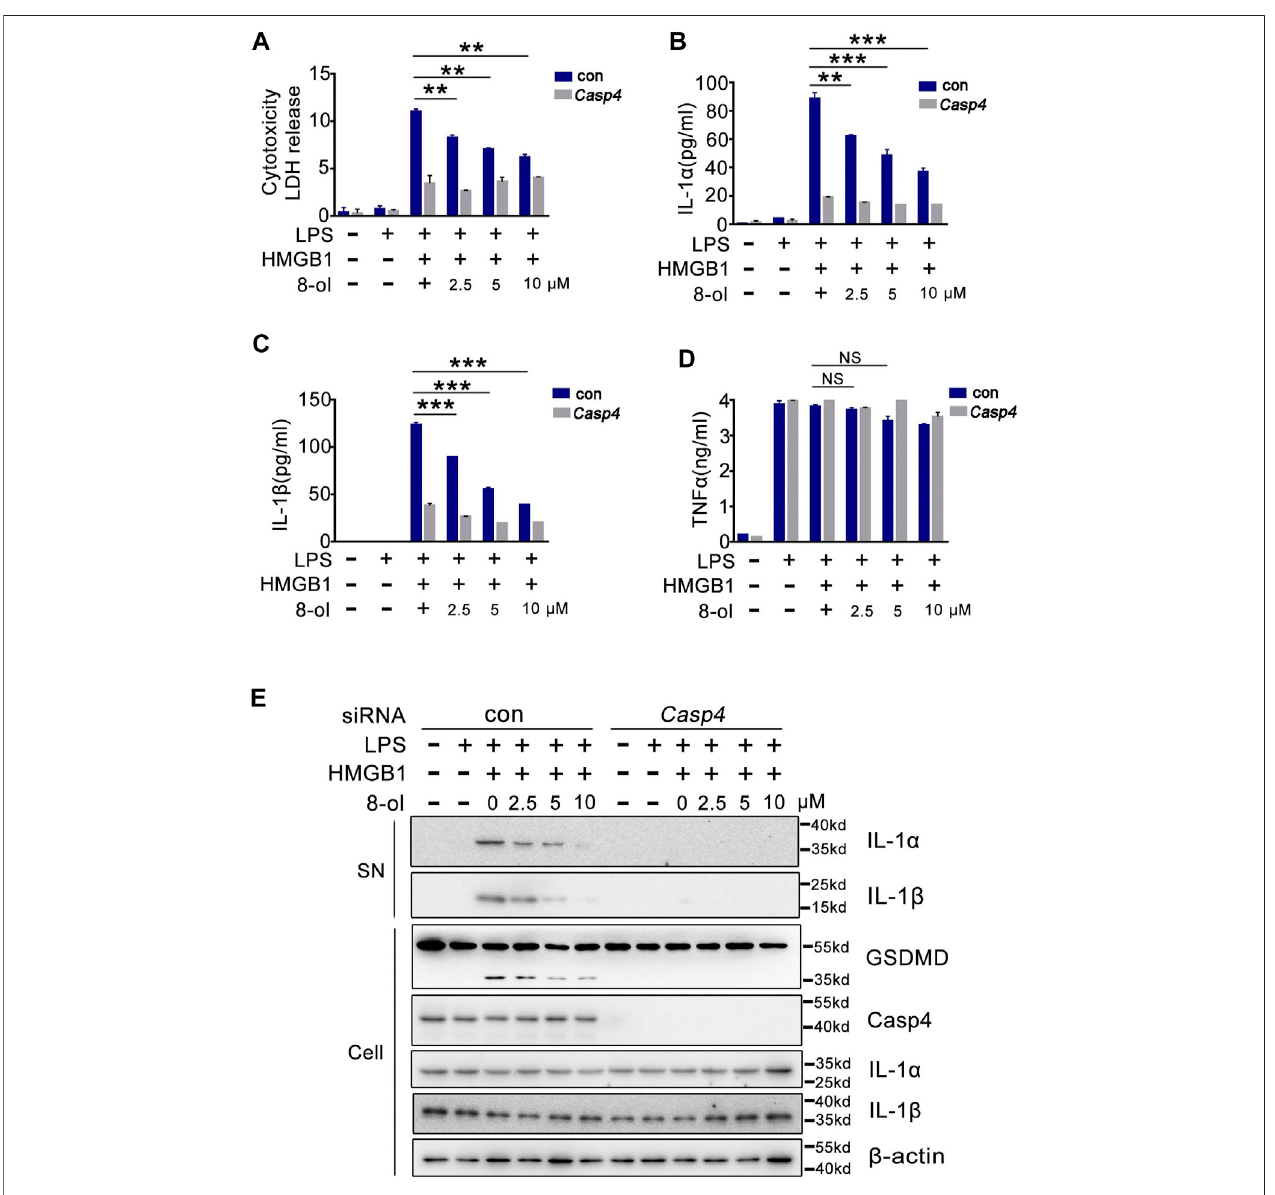
FIGURE3| 8-olinhibitsHMGB1-mediated caspase-4 – dependentpyroptosisinhumanmonocytes. (A – D) LDHandcytokine(IL-1 α ,IL-1 β ,andTNF α )releasefrom PMA-primed human monocytic THP-1 cells transfected withscrambled siRNA orCASP4-speci fi c siRNA upon HMGB1 (400 ng/ml) and LPS (1 μ g/ml)stimulation in the presenceorabsenceof8-ol. (E) WesternblotsforIL-1 α andIL-1 β inthesupernatantorthecleavageofGSDMDandtheexpressionofcaspase-4,IL-1 α ,andIL-1 β inthe cell lysates stimulated with or without the indicated dose of 8-ol. Graphs show the mean ± SD of technical replicates and are representative of at least three independent experiments. * p < 0.05; ** p < 0.01; *** p < 0.001, NS: not signi fi